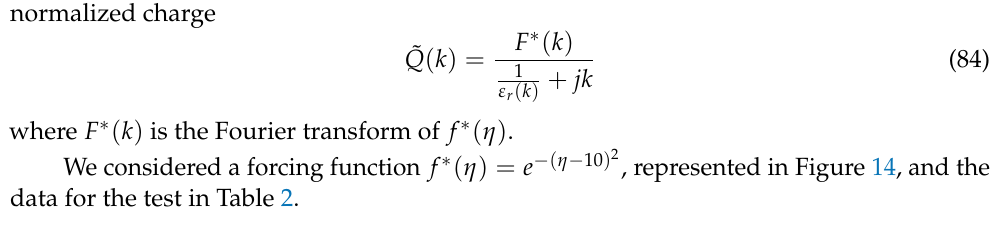
Table 2. Data for the test.